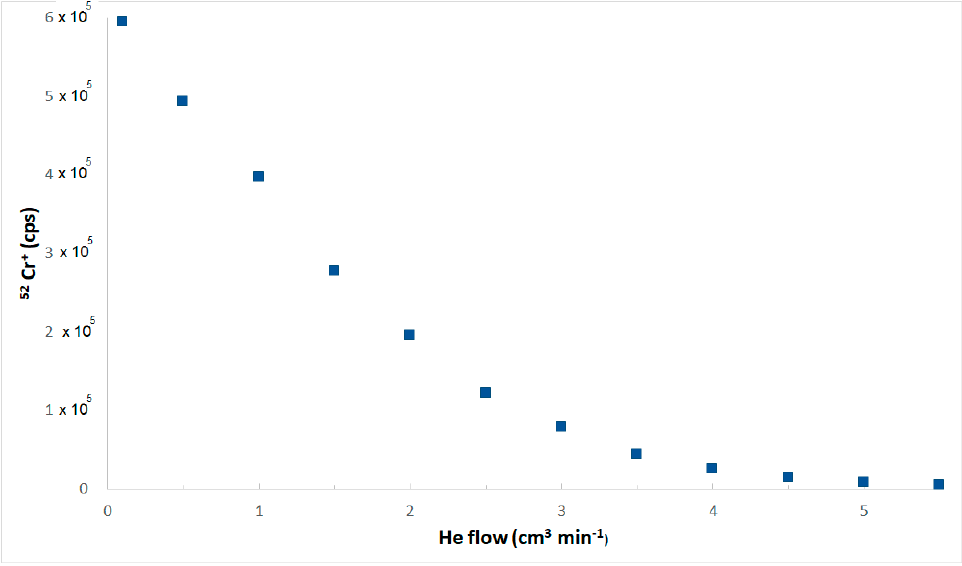
Figure 2. Dependence of the ionic signal of the 52 Cr + ion at variations of the He flow. It is evident that the first linear tract of the curve (He flow up to 2 cm 3 min − 1 ) gives an account for the removal of the molecular ionic interference, likely due to the 40 Ar 12 C + ion, higher than 4 cm 3 min − 1 ) accounts for a slight reduction of signal of the elemental ion as a